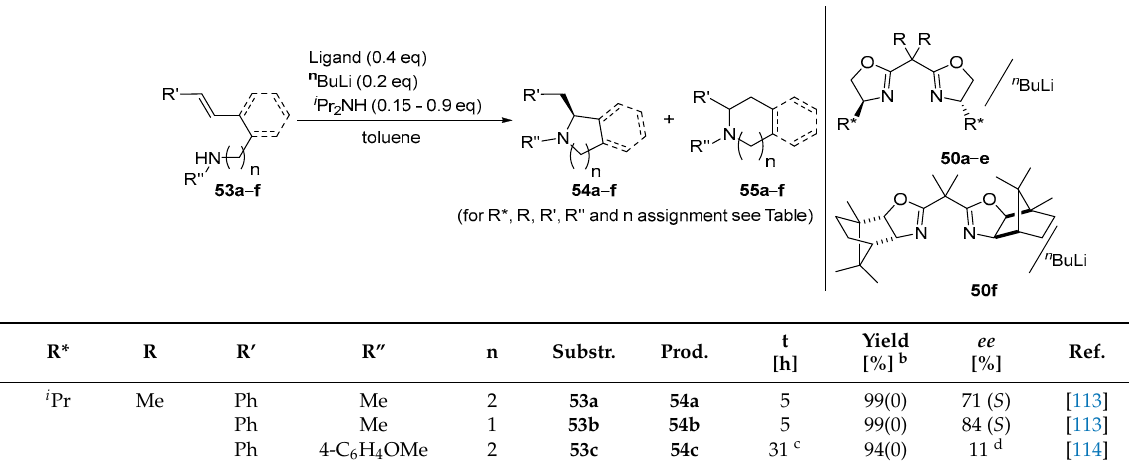
Table 14. Catalytic asymmetric hydroamination of 53a – f using chiral lithium catalysts 50a–f a .